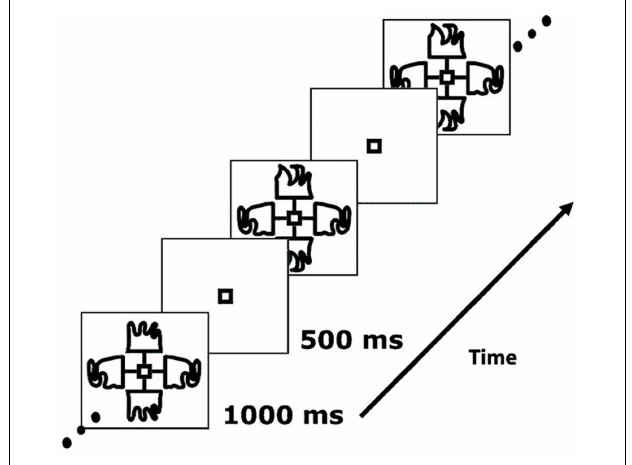
FIGURE 1 | Example of a stimulus sequence used in the task (29) .